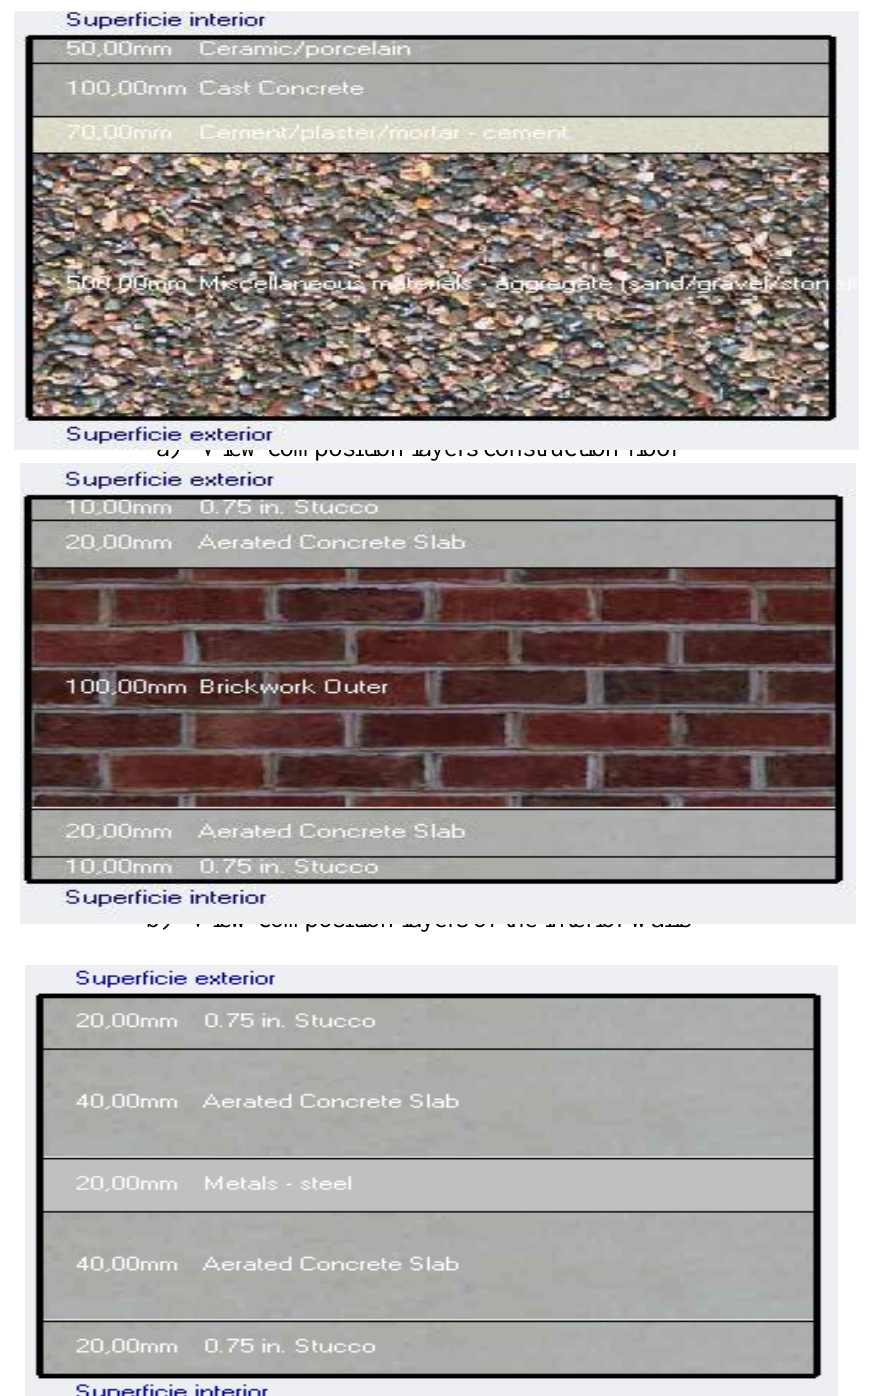
Figure 2. Composition of outer and inner envelopes of the case